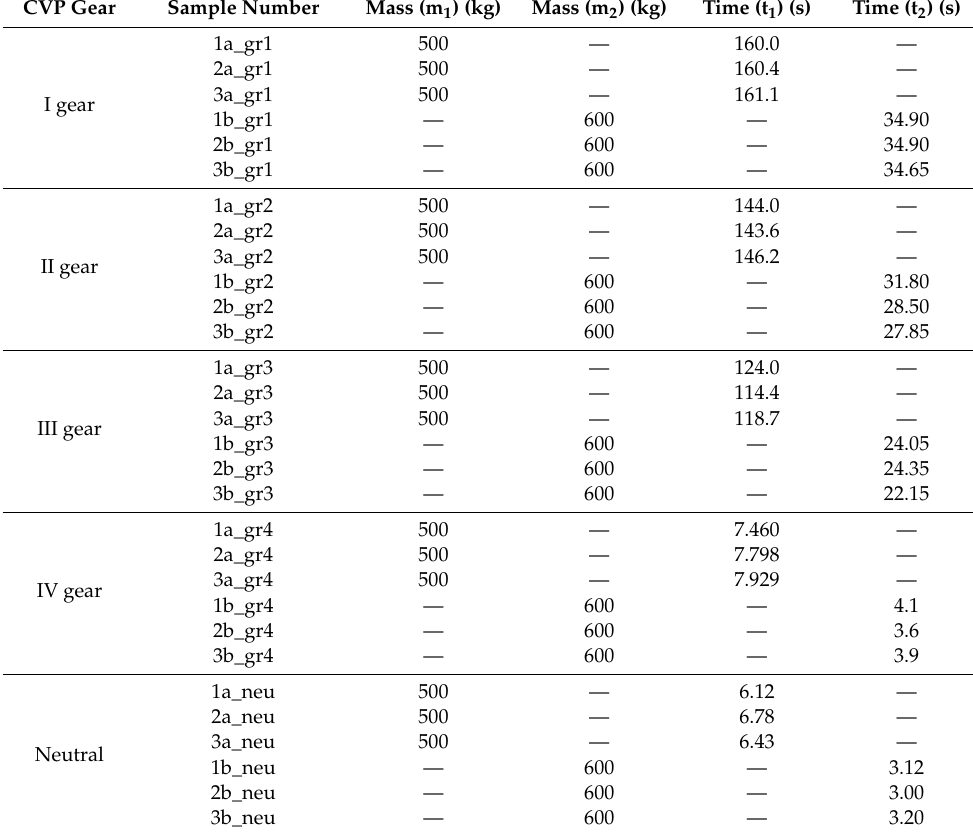
Table 2. Experimental data obtained by applying the classical gravitational